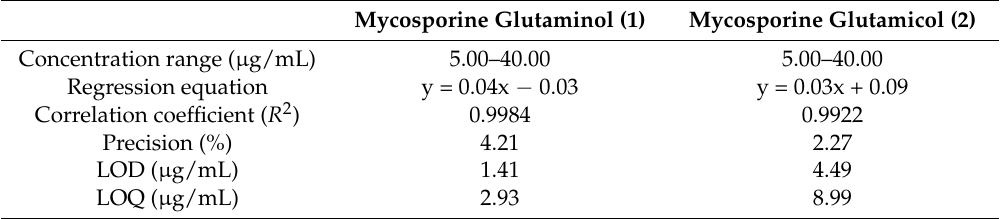
Table 1. Validation results of the hydrophilic interaction liquid chromatography (HILIC) method for